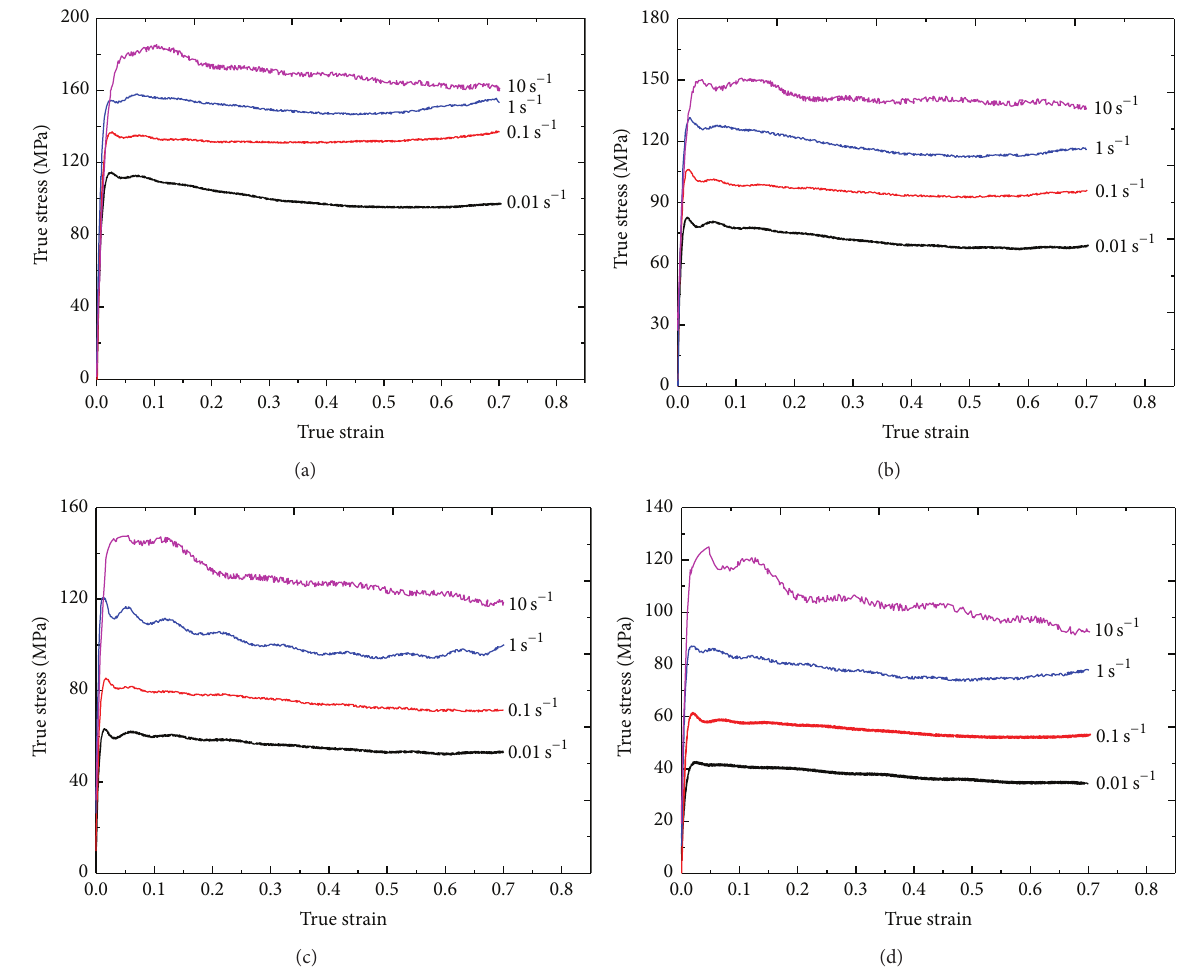
Figure 1: Flow stress-strain curves with (a) 300 ∘ C; (b) 350 ∘ C; (c) 400 ∘ C; (d) 450 ∘ C.